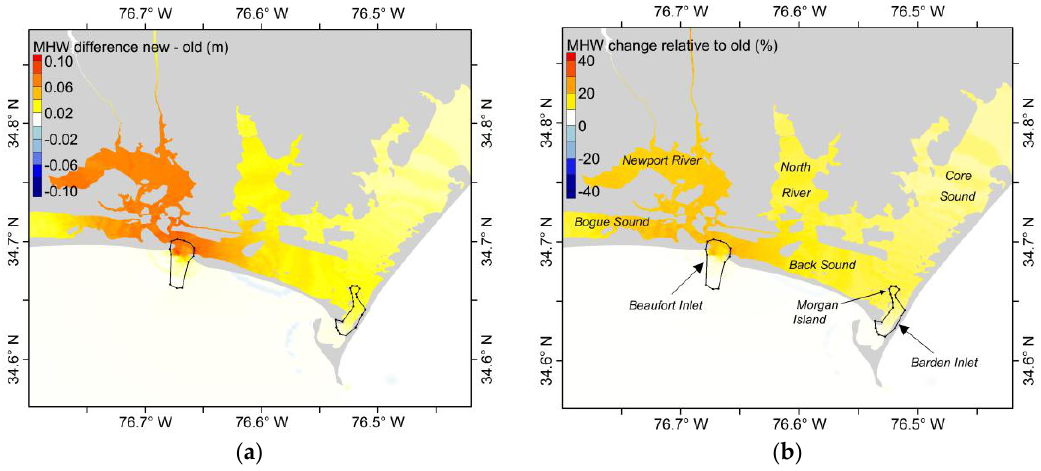
Figure 10. The MHW changes induced only by the inlet morphological changes around Beaufort Inlet: ( a ) the MHW difference between the new-bathy-BE model and the old-bathy model; ( b ) the MHW change in percentage relative to the old-bathy model MHW. The black dotted polygons delineate the area with changed bathymetry.